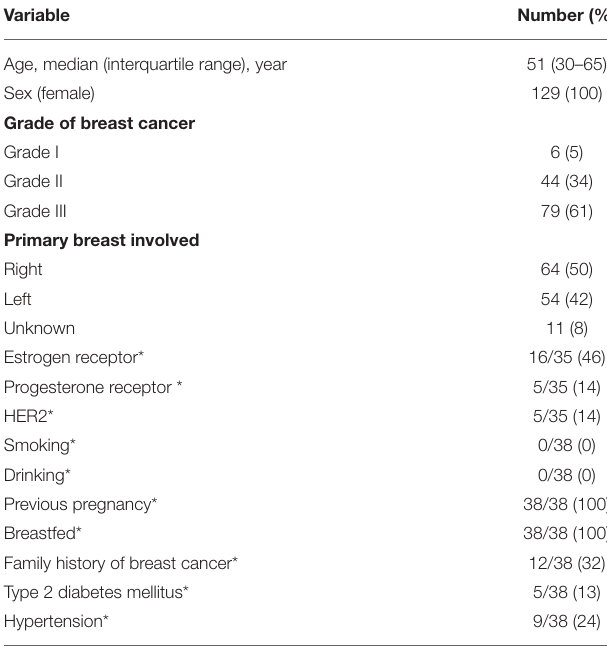
TABLE 1 | Demographics of study